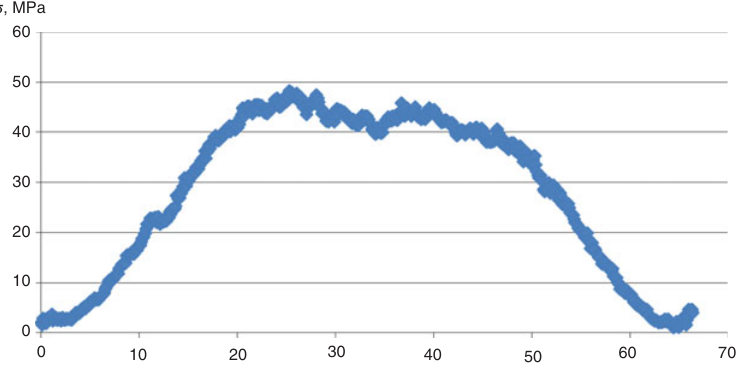
Fig. 9. Von Misses law of variation of equivalent stresses depending on time during the work cycle of a crane